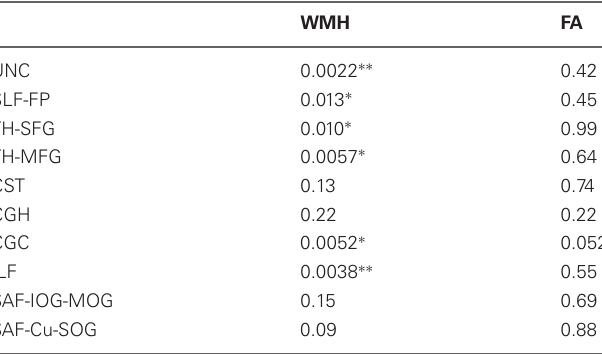
Table 2 | Tract-based multiple regression model p -values for WMH and FA covariates for 10 separate models.